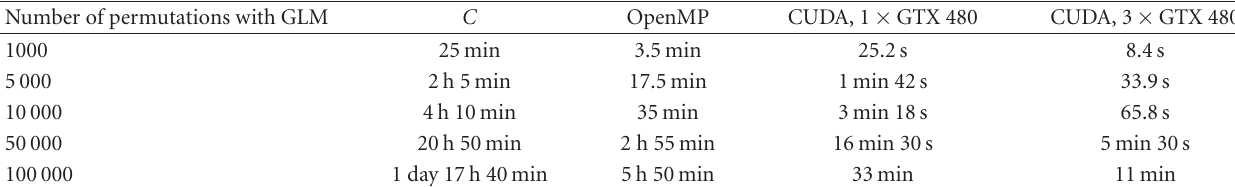
Table 2: Processing times for random permutation tests with the GLM for the di ff erent implementations.